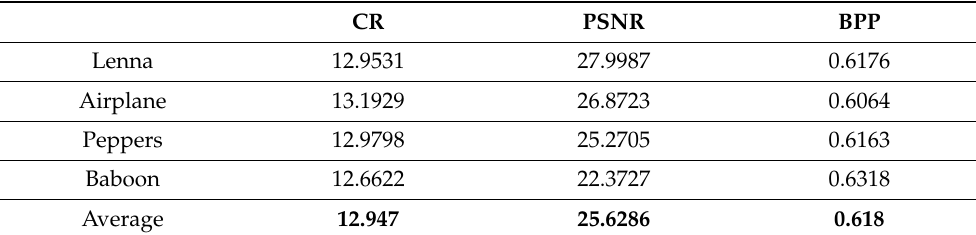
Table 5. Resulting in CR, PSNR, and BPP using the test images in Figure